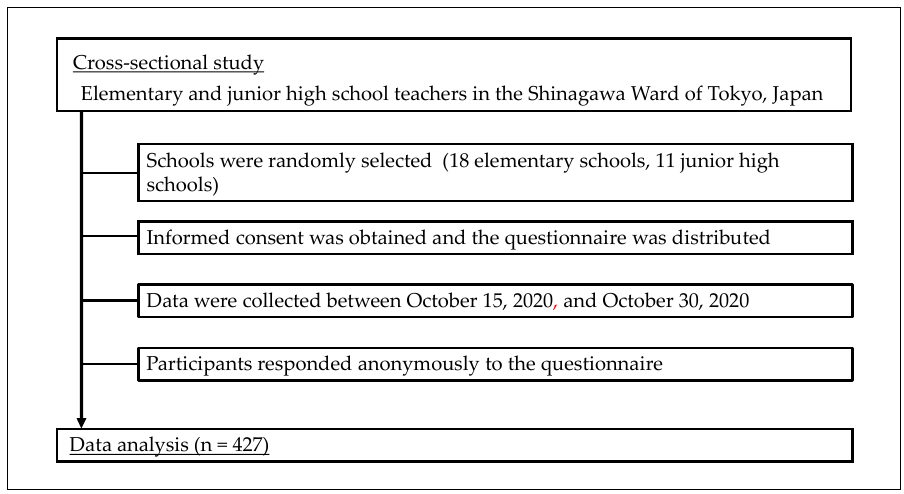
Figure 1. Flow-chart of the cross-sectional study.